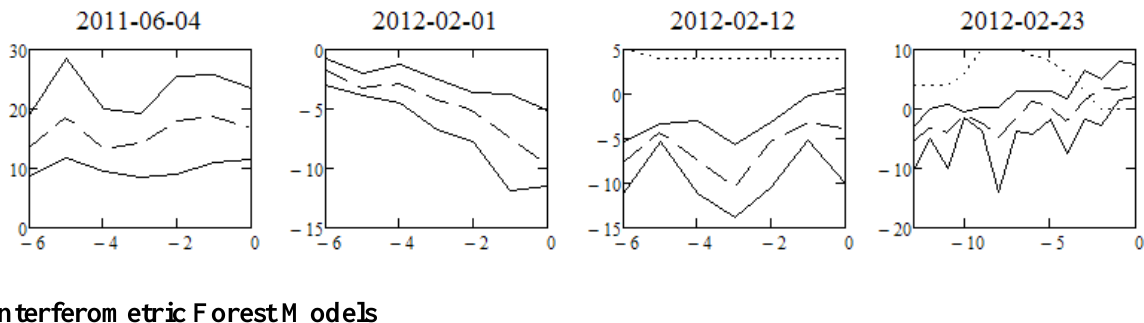
Figure 4. History of temperature for the Remningstorp test site prior to four TDM acquisitions with |HOA|  80 m. The units on the x- and y-axis are days and temperature (  C), respectively. The snow layer in cm is dotted for the acquisition dates 2012-02-12 and